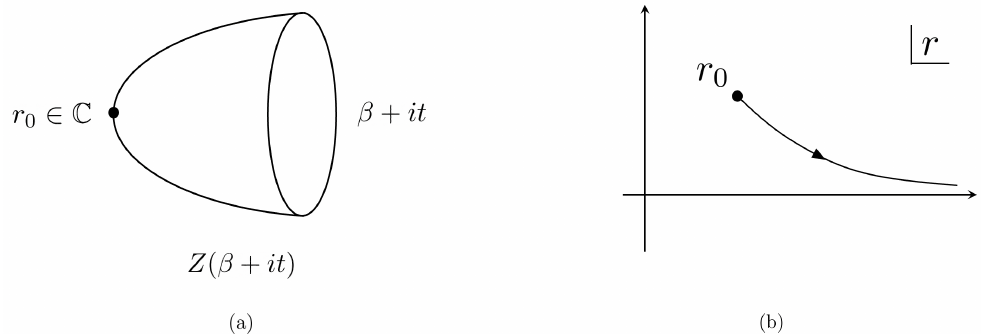
Figure 14 . (a) The computation of Z ( β + it ) involves a complex black hole. (b) The location of the complex Schwarzschild radius on the complex plane and a contour that connects it to